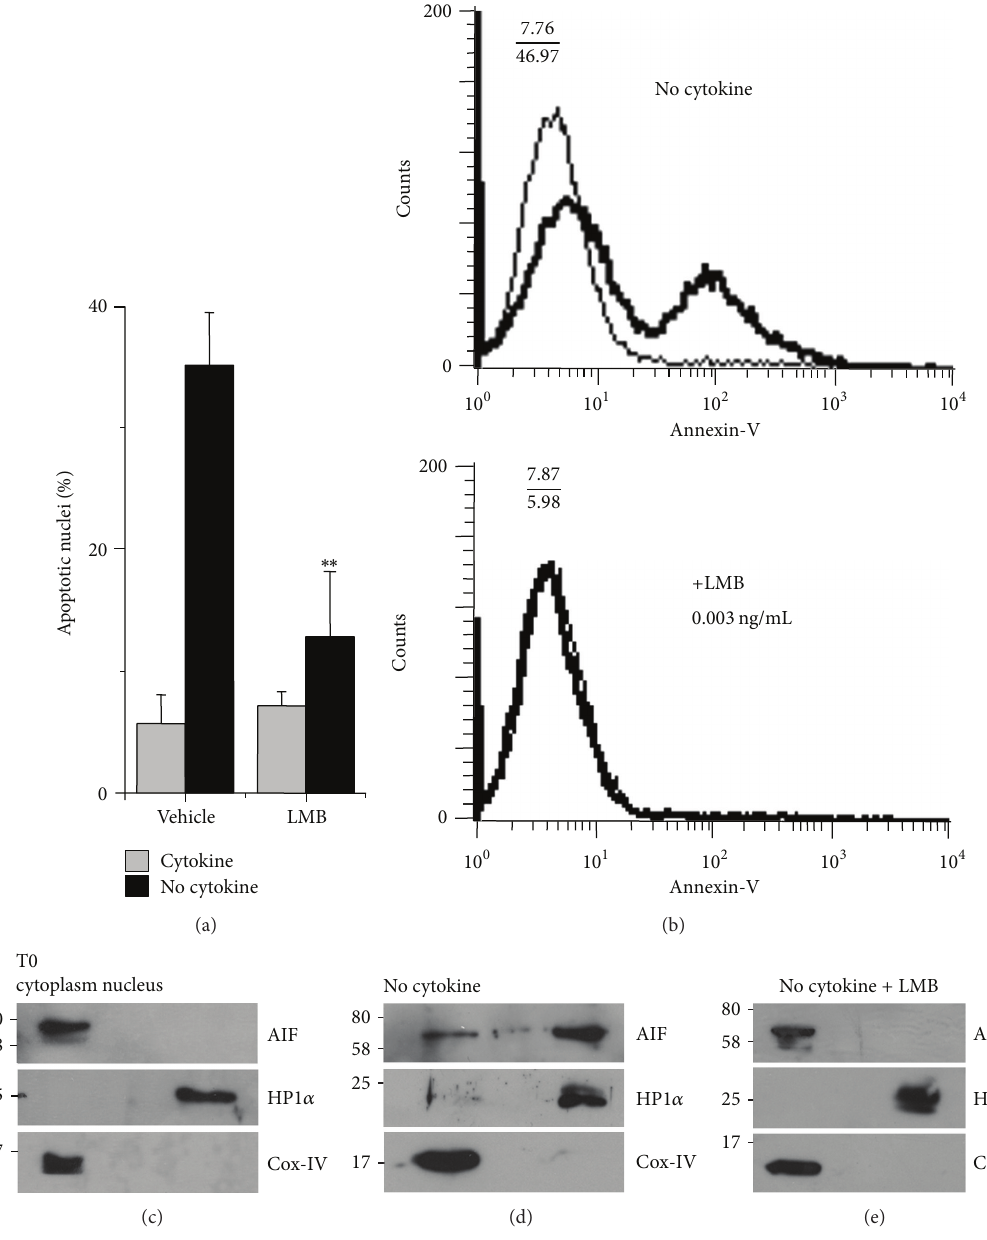
Figure 1: LMB blocks cytokine deprivation induced apoptotic damage in T-effectors. (a)-(b) 0.3 × 10 6 T-effectors were cultured with or without IL-7 (20ng/ml) with the addition of vehicle control or LMB (0.003 ng/ml). Apoptotic nuclear damage (a) and Annexin-V binding (b) were scored after 8 and 15 hours, respectively. The dotted lines in (b) indicate cells continued in cytokine. The graph shows mean ± SD from 4 experiments. ∗∗ 𝑃 < 0.001 . (c)–(e) 10 × 10 6 T-effectors were cultured in the indicated conditions (T0: freshly activated) and 8 hours later cells were fractionated as described in Materials and Methods. Immunoblots of nuclear and cytoplasmic fractions obtained were probed for AIF, HP1 𝛼 , and Cox-IV. Data are representative of three independent